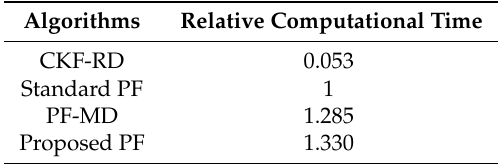
Figure 9. RMSE of different filters for measurements with no packet drops considering p = 0.5. ( a ) State x 1, k ( b ) State x 2, k (Problem 2). Table 3. Relative computational time for different